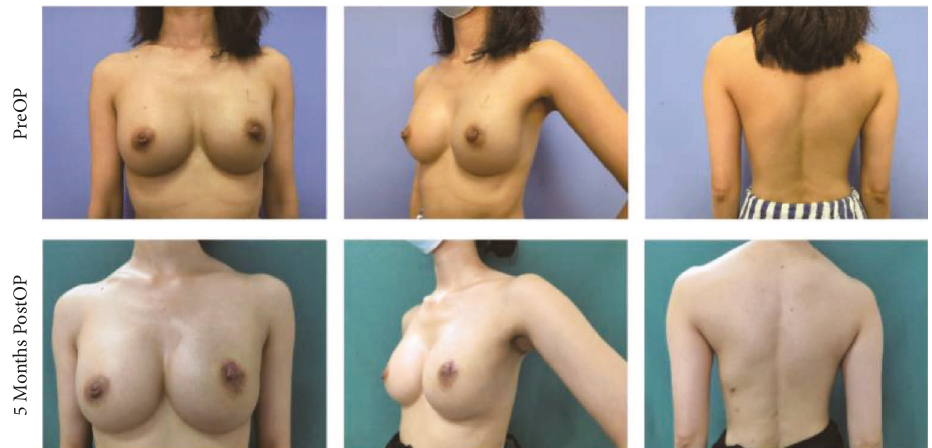
Figure 7: A 36-year-old woman undergoing LDMF combined with prosthesis breast reconstruction after E-SSM and E-LDMF harvesting with her preoperative photos and 5 months postoperative photos. She suffered hypopigmentation of the nipple